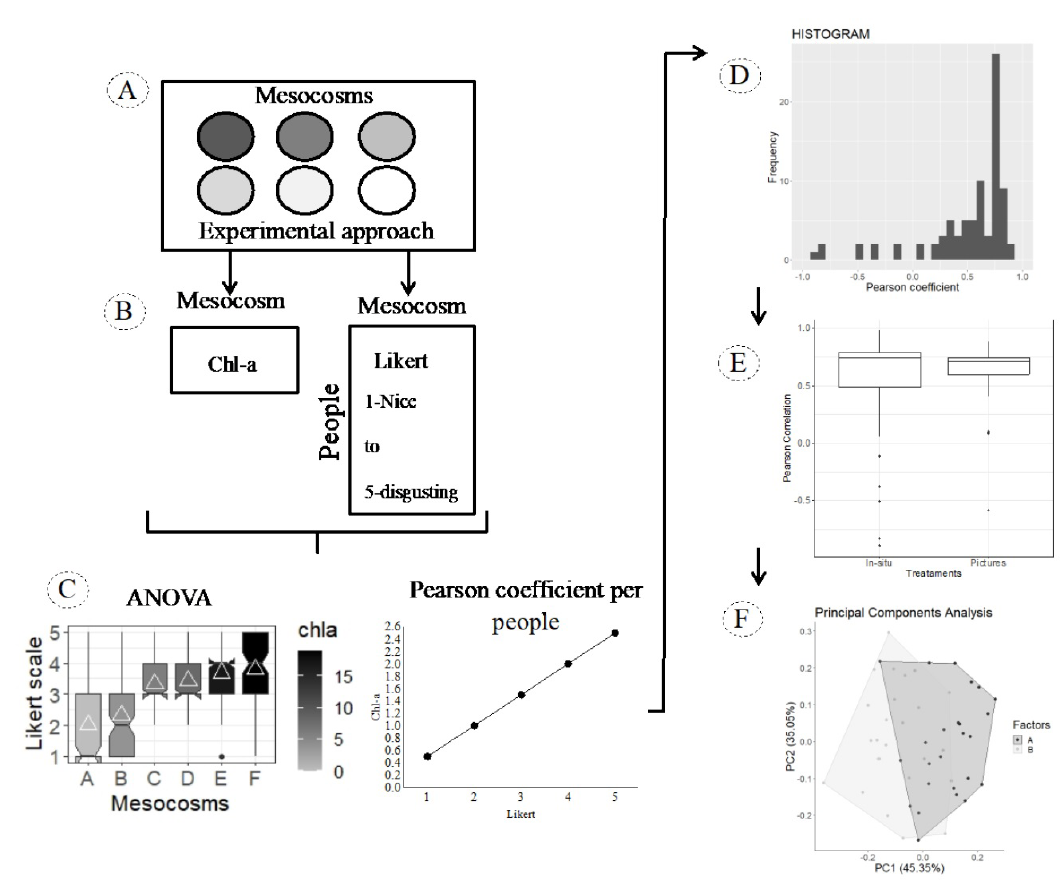
Figure 1. Schematic protocol used in the presented study. The mesocosms installed had a strong gradient of eutrophication according to the concentration of Chlorophyll-a (A). People were invited to respond to questionnaires with questions about the water quality of the mesocosms (B). People visualized the mesocosms in the experimental area (in-situ approach) or through pictures. People’s perception of water quality (Likert scale) was analyzed in two ways: One-Way ANOVA comparing the mesocosms, and pearson correlation, to evaluate the relationship of Likert scale with the Chlorophyll-a concentration of the mesocosms (C). We used the result of Pearson correlation to estimate the histogram of r values (D), compare the visual perception obtained in-situ and through pictures (E), and summarized and modeled with predictor variables (gender, formal education, and frequency of visits to aquatic environments) using the PERMANOVA